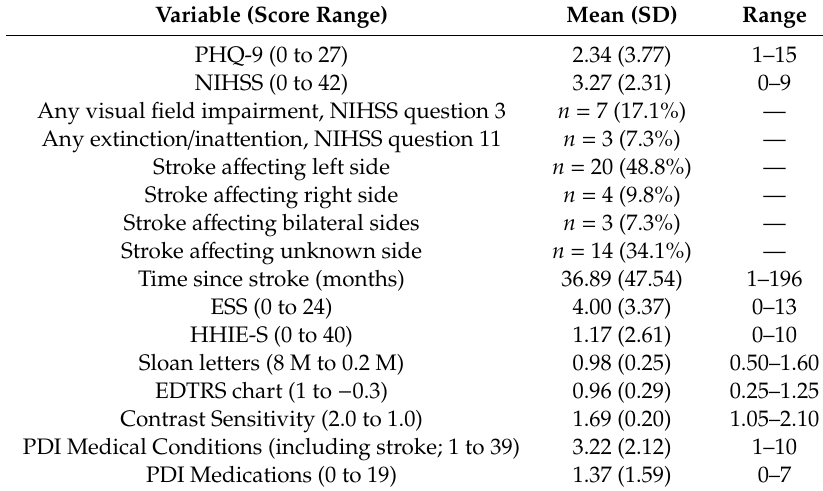
Table 3. Clinical characteristics of study sample.